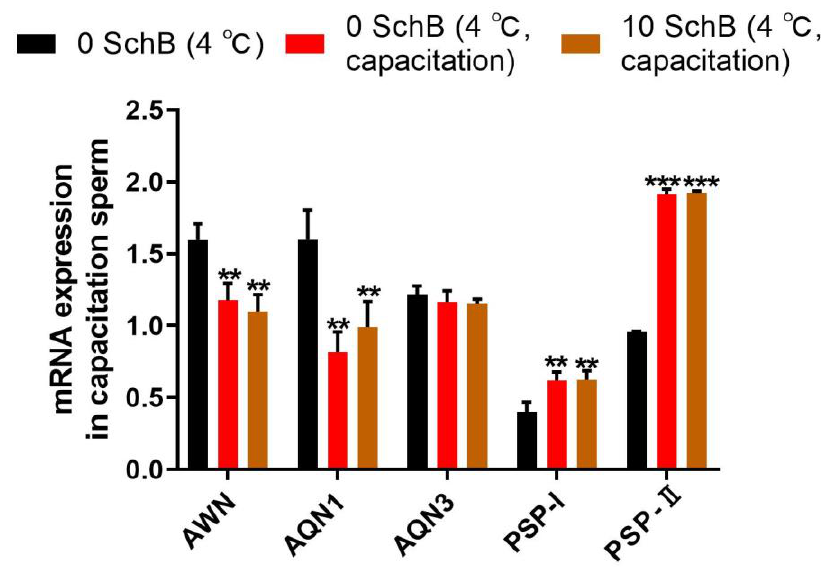
Figure 10. Effects of Sch B on mRNA expression of AWM, AQN1, AQN3, PSP-I, and PSP-II in capacitated boar sperm: Data are expressed as mean ± SD ( n = 12). *** p < 0.001 and ** p < 0.01 vs. 0 Sch B.